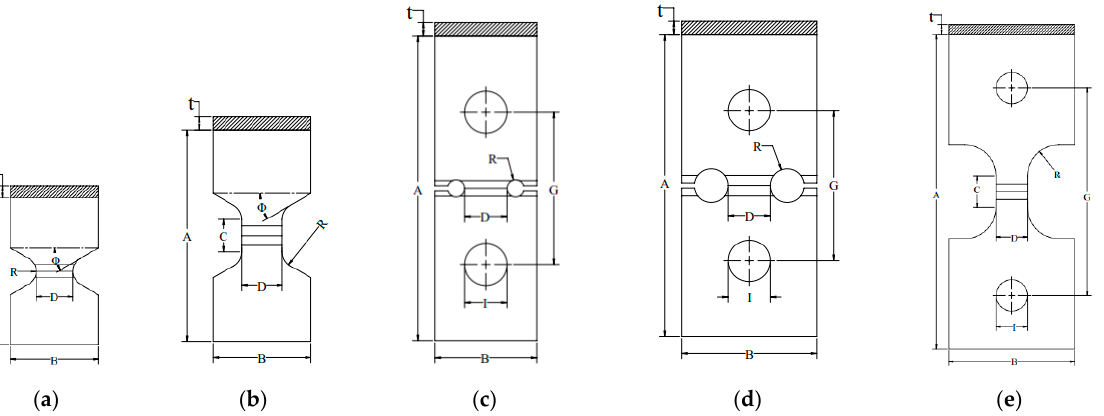
Figure 3. Shape and relative dimensions: ( a ) Type A TWT specimen ( t < 25 mm); ( b ) Type B TWT ( t ≥ 25 mm); ( c ) Type A WT specimen ( t < 25 mm), d n ≤ 160 mm; ( d ) Type A WT ( t < 25 mm), d n ≤ 160 mm; ( e ) Type B WT ( t ≥ 25